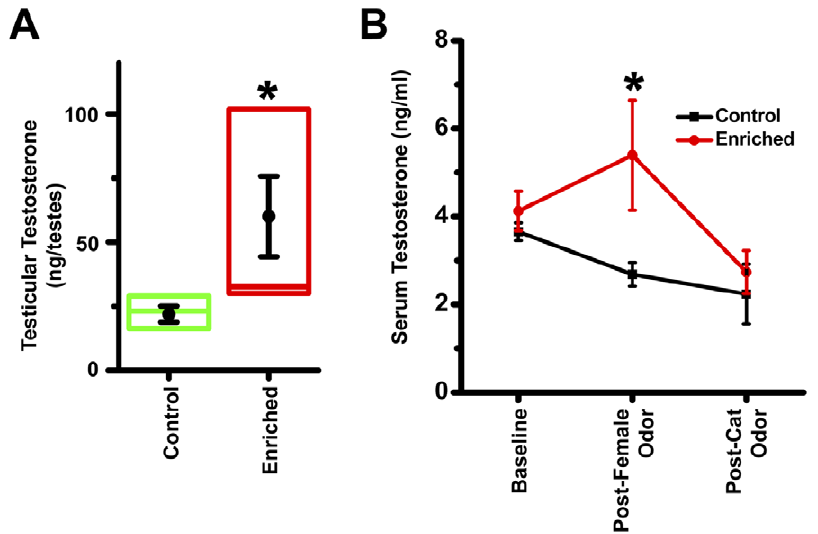
Figure 2. Enriched males have higher testosterone. Gonads of enriched animals contained more testosterone (A). n=8 males for each group. Box plots all through the figure depict median, 25 th percentile and 75 th percentile. Dot and whiskers represent mean and SEM. *, p , 0.05; exact Mann- Whitney test. Enriched animals secreted more testosterone in blood when presented with an estrous female, an effect absent in control males (B). n=6 males for each group. *, p , 0.05, exact Mann-Whitney test between control and enriched.